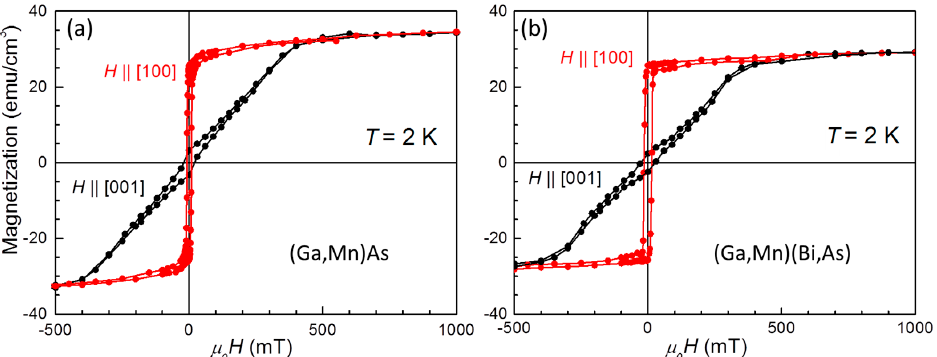
Figure 4. Magnetic field H dependence of the in-plane magnetization, represented here by the [100] one (red symbols), and of the perpendicular one (black symbols) measured at temperature T = 2 K for ( a ) (Ga,Mn)As and ( b ) (Ga,Mn)(Bi,As) layers studied here.